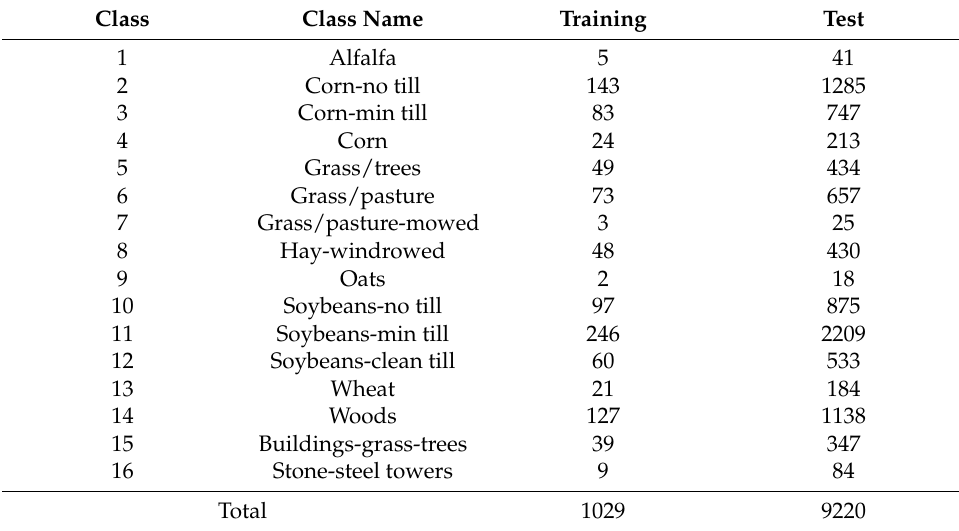
Table 1. Class information for the Indian Pines